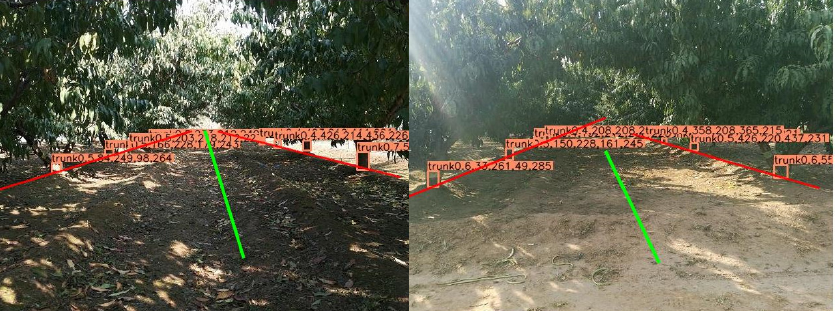
Figure 12. Centerlines of fruit rows calculation in the orchard.